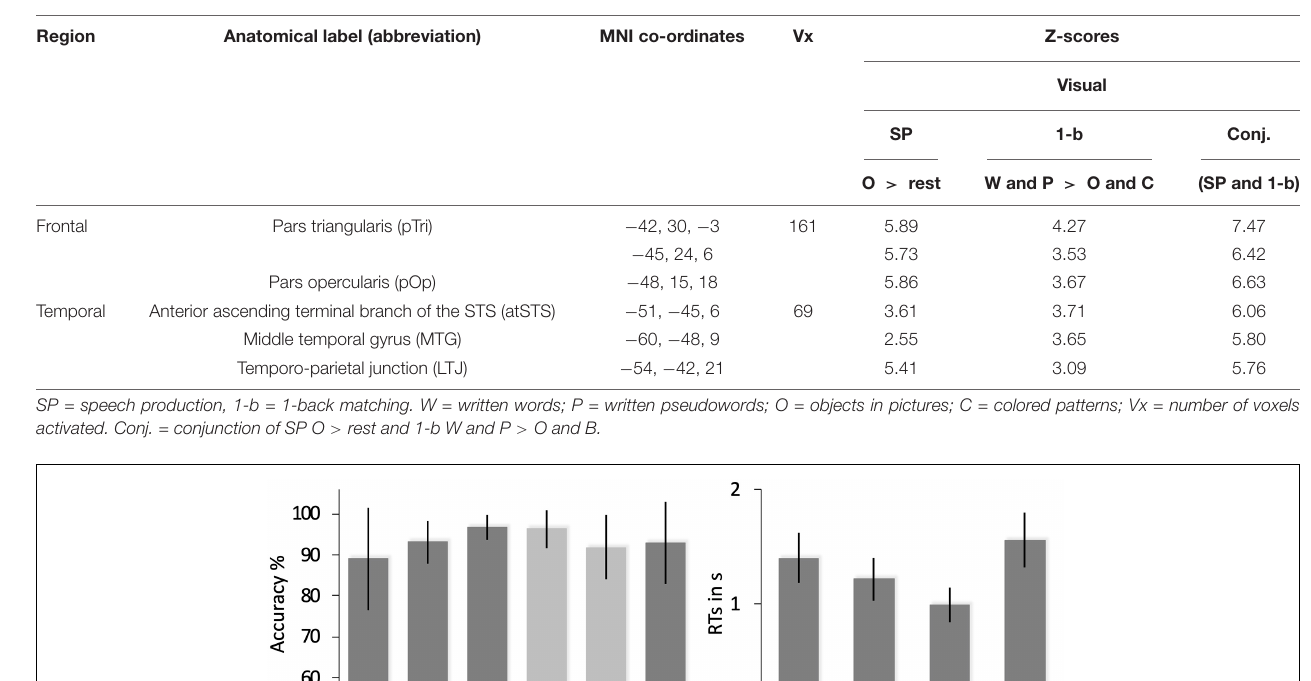
TABLE 2 | Statistical details for regions of interest.